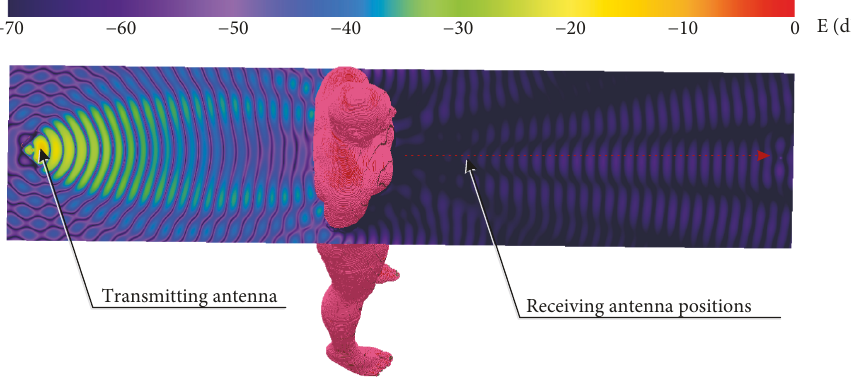
Figure 7: Simulation results for electric fi eld strength obtained using FDTD — body orientation 1.